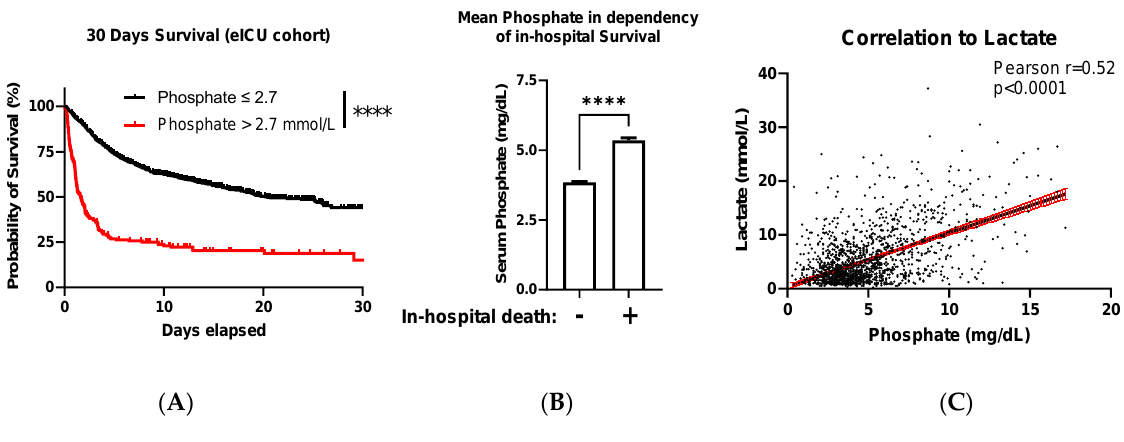
Figure 5. ( A ) Kaplan–Meier curve of patients after ROSC with initial serum phosphate >2.7 mmol/L (red) or ≤ 2.7 mmol/L (black) from the eICU database (Log-rank (Mantel–Cox) test: **** p < 0.0001). ( B ) Mean initial phosphate levels (maximum value of first hospital day) of patients from the eICU database, in dependency of their hospital survival (mean phosphate: 3.8 ± 0.03 (SEM) vs. 5.4 ± 0.09 mg/dL; Mann–Whitney test: **** p < 0.0001). ( C ) Correlation between the initial serum lactate and phosphate levels, Pearson r = 0.52 (95% CI: 0.49 to 0.56, R2 = 0.27, p <